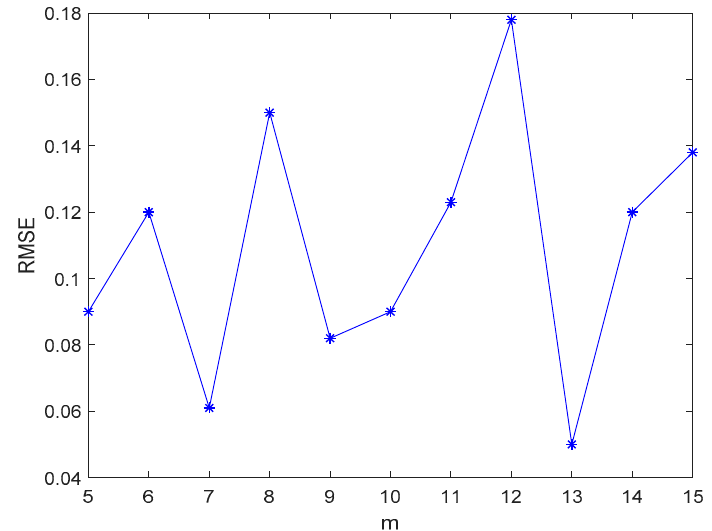
Figure 7. the variation of the RMSE of the LSTM network with m.